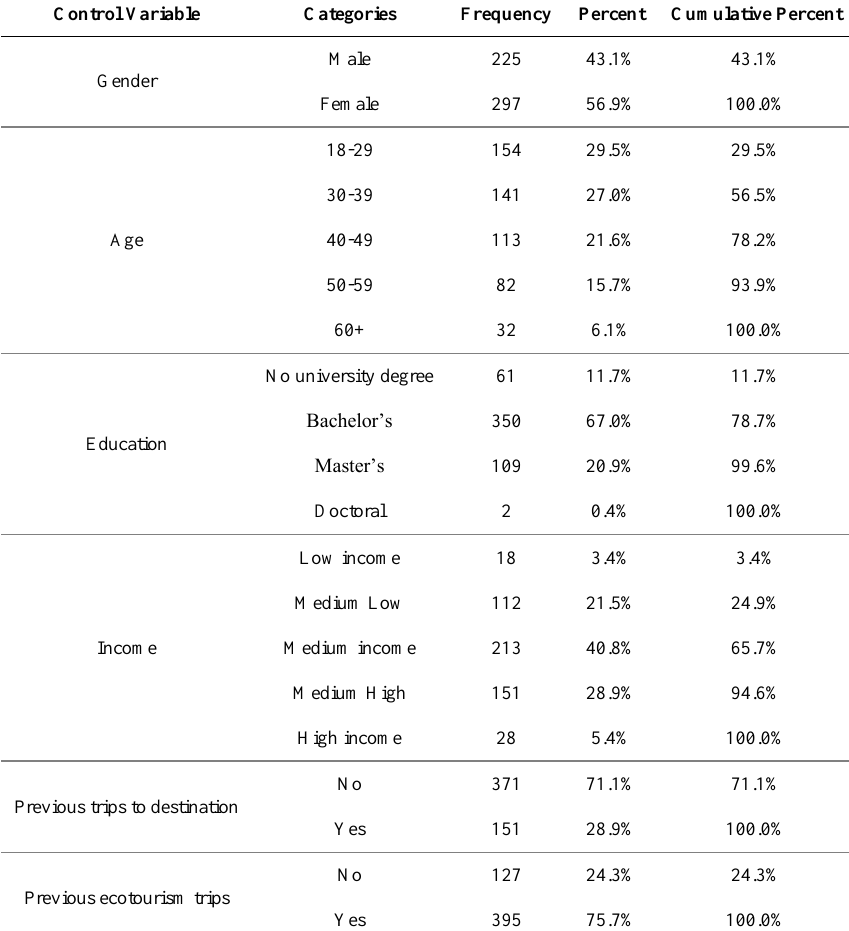
Table 1. Background